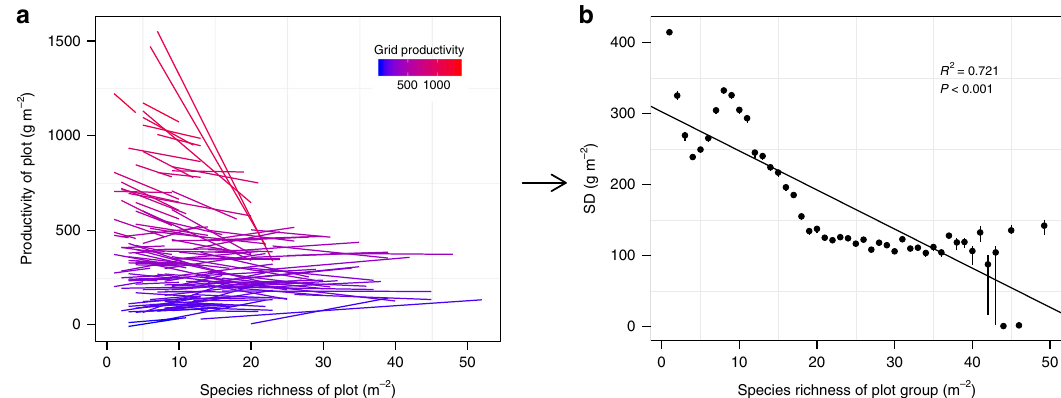
Fig. 4 Relationships between species richness, productivity and spatial variability of productivity. a Relationships between richness and productivity varied among 151 grids with different average productivity or stress gradients in natural grasslands. b Standard deviation (SD) of productivity (i.e., inverse of spatial stability) decreased with species richness in global natural grasslands. Black points and vertical lines show the medians and 95% credible intervals (CI) of productivity variation for each species richness level. Source data are provided as a Source Data fi le